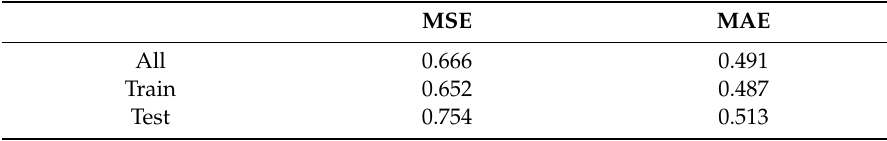
Table 3. Metrics for the random forest (RF) regression model for cost.